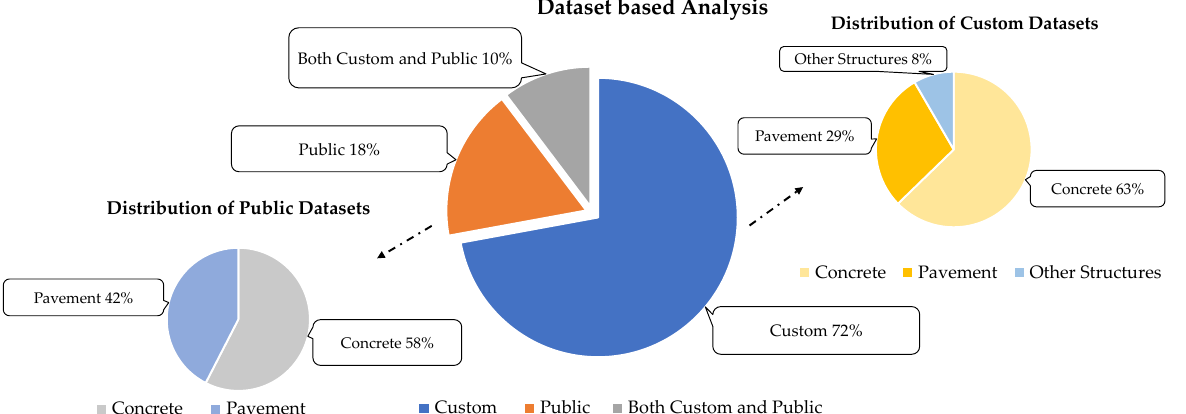
Figure 9. Distribution of retrieved articles based on the dataset.